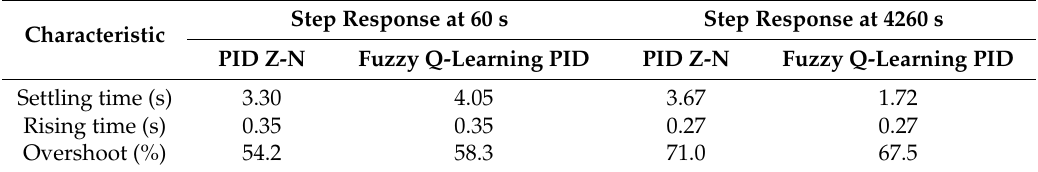
Table 2. Performance characteristics.